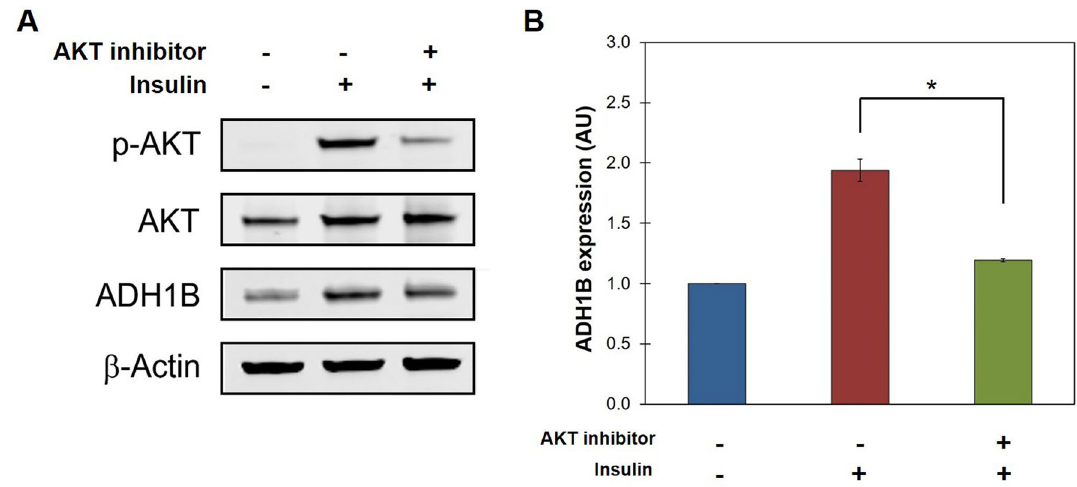
Figure 6. AKT is involved in insulin-mediated ADH1B expression. ( A ) Representative composite image of ADH1B expression with ( +) and without (−) treatment with AKT inhibitor and/or insulin. Following differentiation, cultured adipocytes were starved for 12 h and then treated with 20 µM AKT1/2-specific inhibitor (+ AKT inhibitor) for 1 h prior to treatment with 1.0 µM insulin (+ Insulin) for 1 h. Non-treated cells (−Insulin, −AKT inhibitor) were utilized as control. Total protein was isolated, resolved by SDS-PAGE, and immunoblotted with antibodies specific for phosphorylated AKT (p-AKT) or total AKT and ADH1B. β-Actin was used as loading control. A representative full-length blot is presented in Supplementary Figure S16. ( B ) Quantitative analysis of ADH1B expression relative to non-treated control. Western blot analysis was performed in triplicate. Fluorescence intensity was quantified and normalized to β-Actin control. Data is presented as the mean ± s.e.m. AU, Arbitrary Units; *P < 0.01.